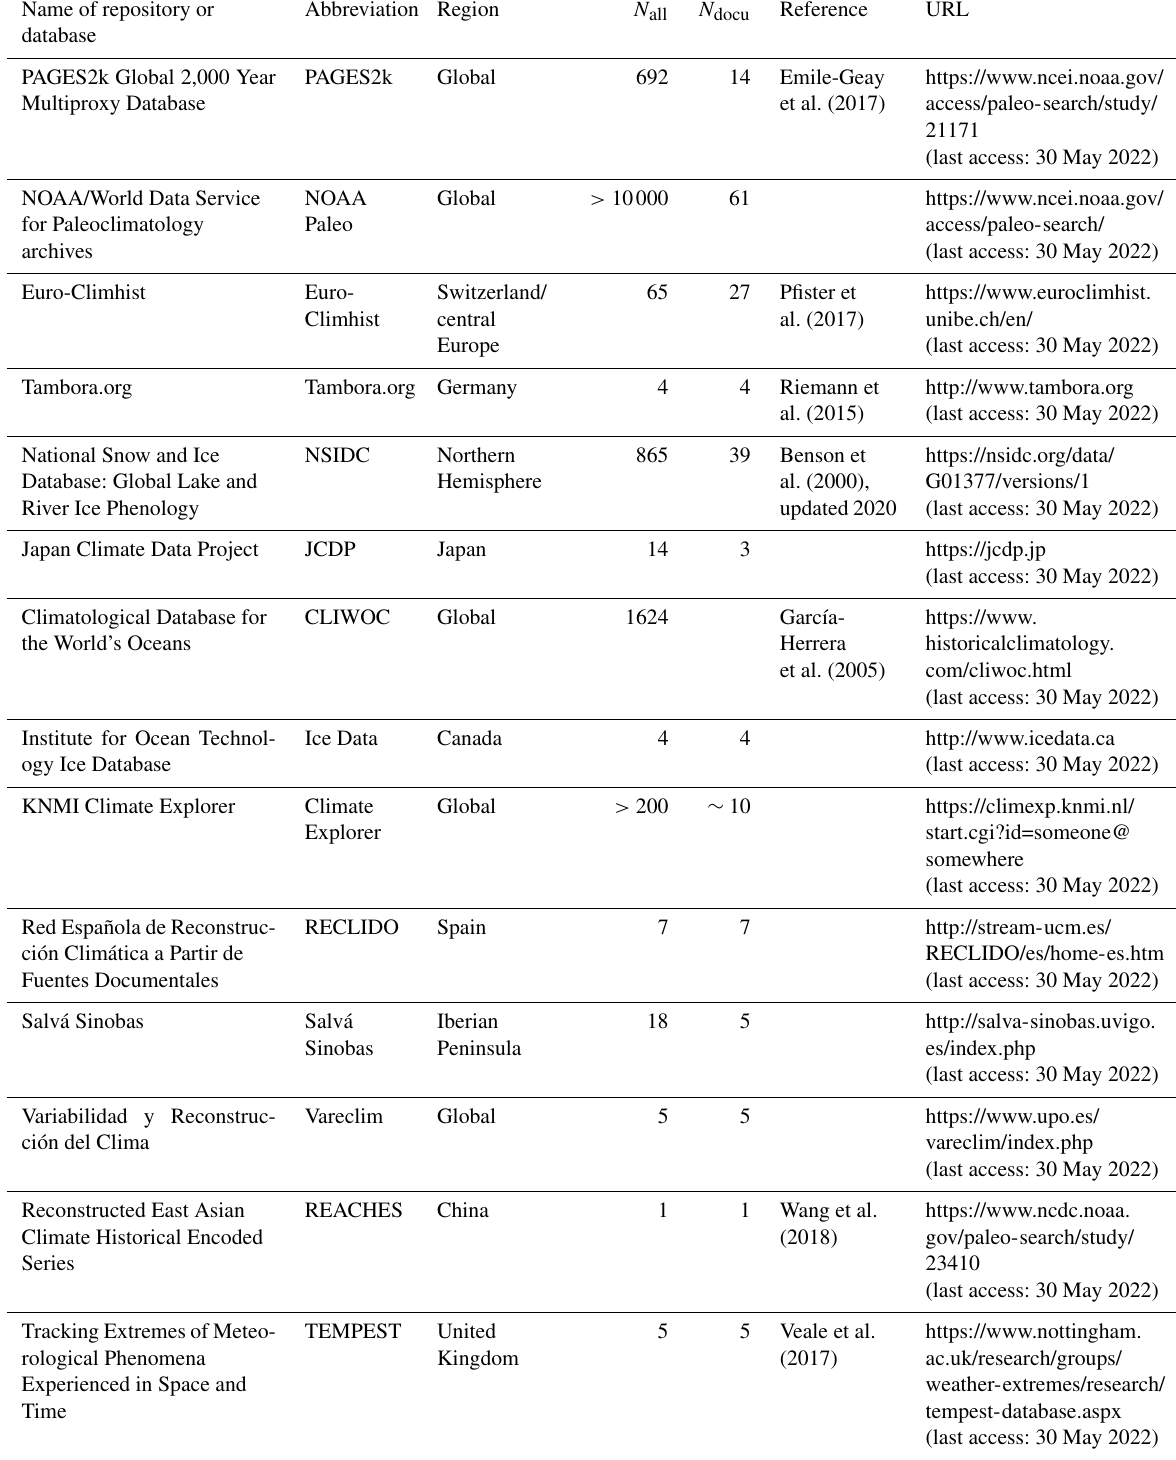
Table 1. Overview of available global and national repositories and databases containing documentary evidence. N all is the total number of series available on the platform, and N docu is the number of series or databases based on documentary evidence available prior to